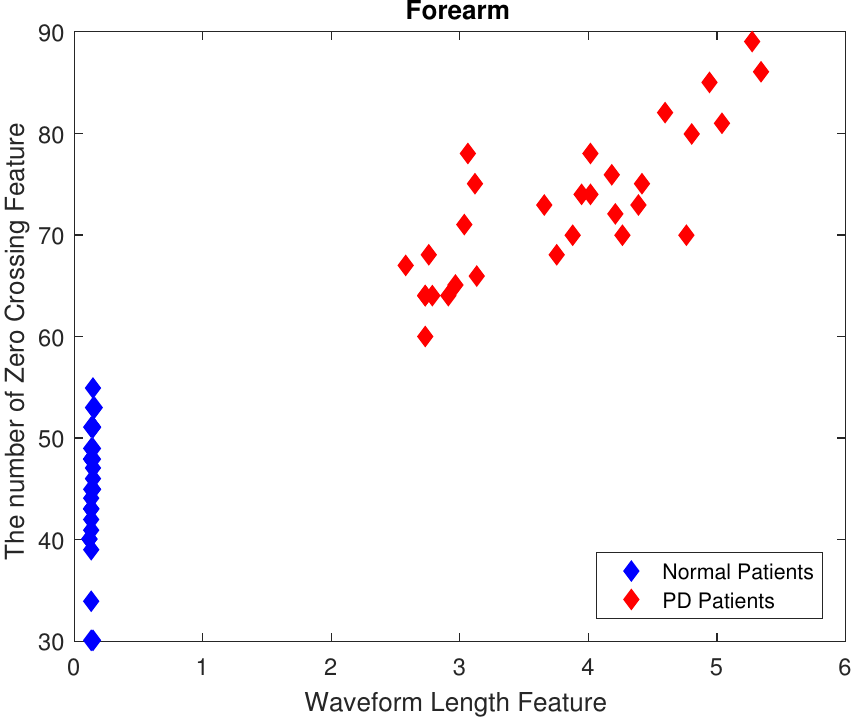
Figure 14. Two-dimensional scatter plot of ZC feature vs. WL feature of forearm sEMG sensor for normal and PD